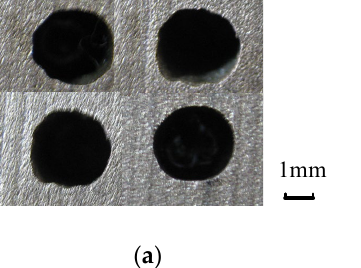
Table 2. Composition table of high temperature nickel-based alloy GH4169.